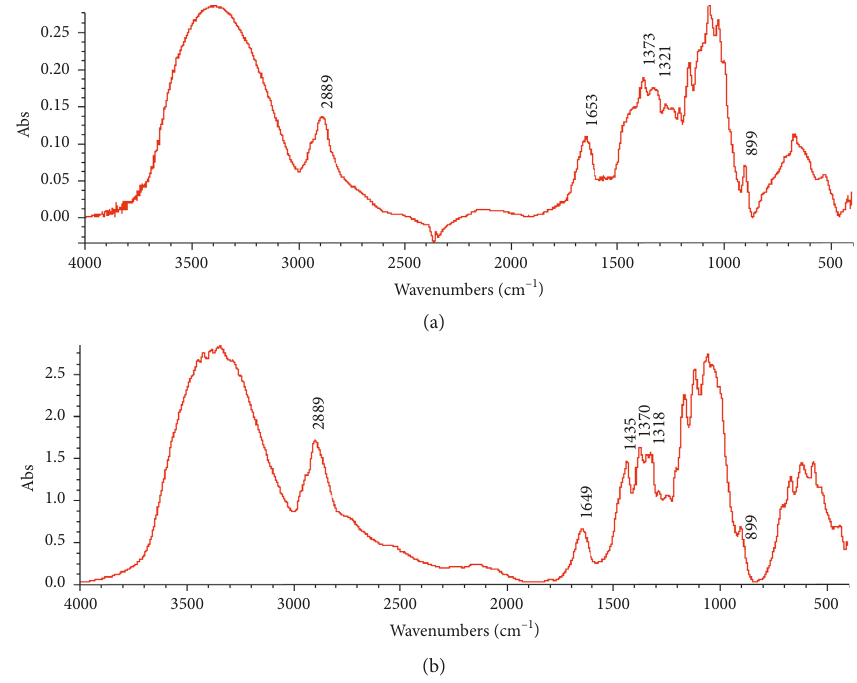
Figure 2: FTIR spectra of original cellulose (b) and the spherical particles fractionated from acetonitrile